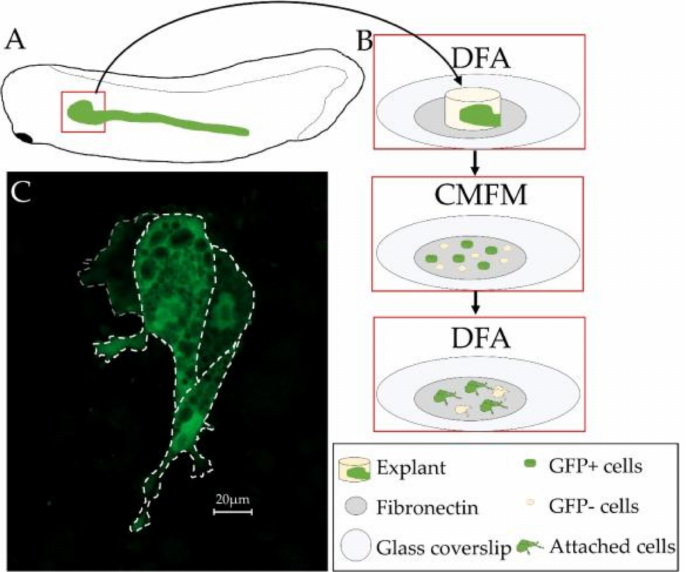
Figure 7. X. laevis cdh17 :eGFP transgenic line is useful for primary culture of kidney tubules. ( A ) Diagram showing region of embryo that was explanted. ( B ) Schematic of methodology used to culture cells. Media used for each step is as indicated DFA (Danilchik ’ s for Amy) and CMFM (Calcium Magnesium Free Media). ( C ) Image of GFP-positive cells cultured for 24 h in DFA. Cells are outlined using dashed